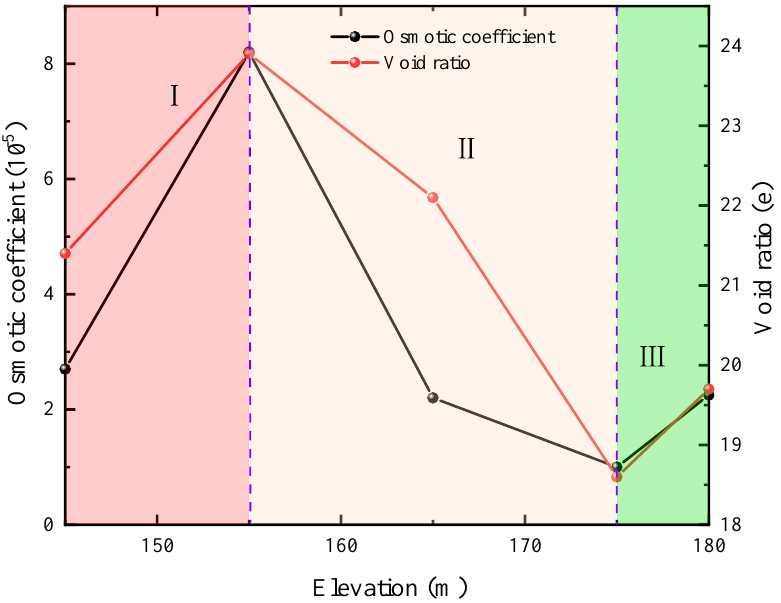
Figure 5. Permeability coefficient and pore ratio of soil with different elevations.